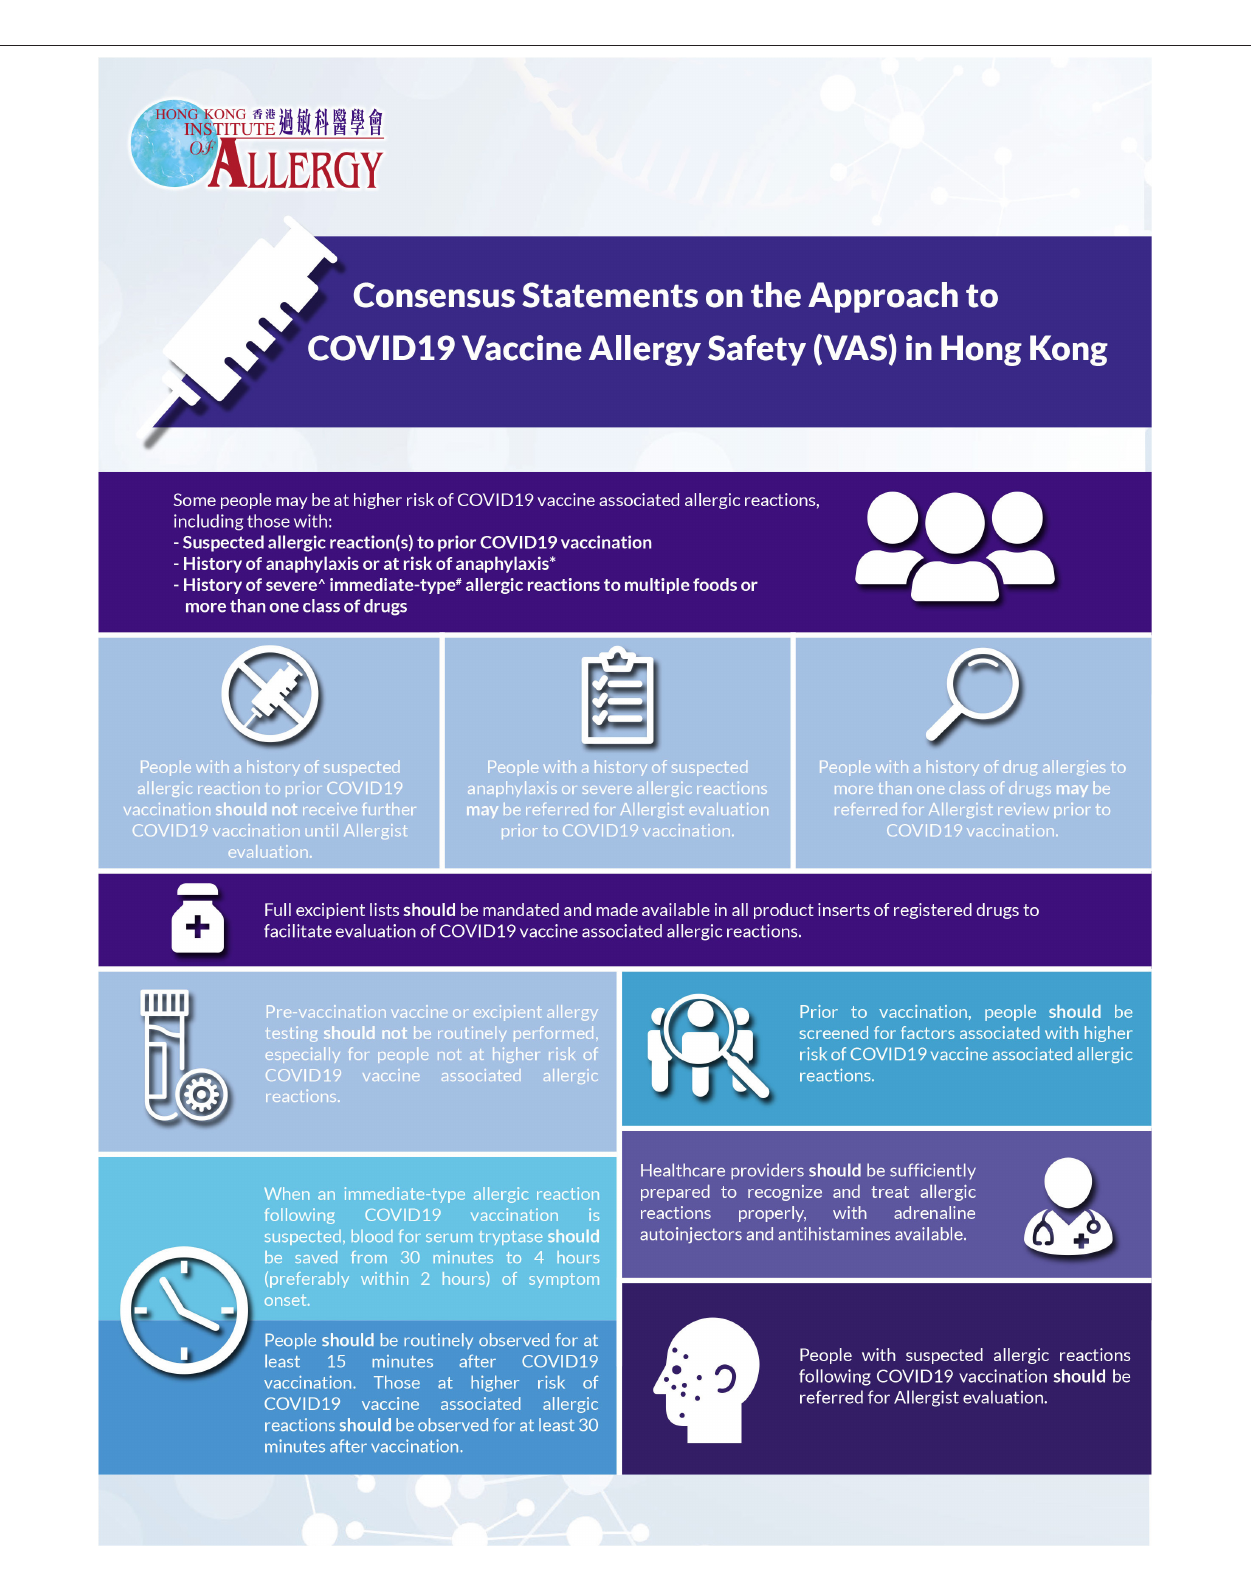
Frontiers in Allergy | www.frontiersin.org